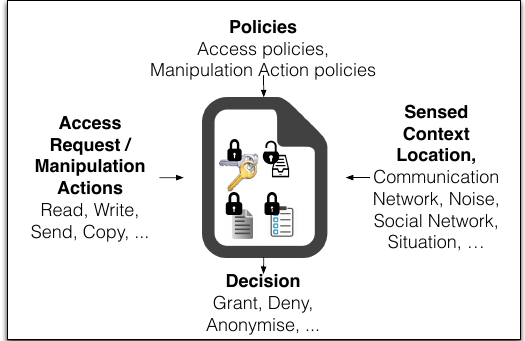
Figure 2. Generic SmartContent